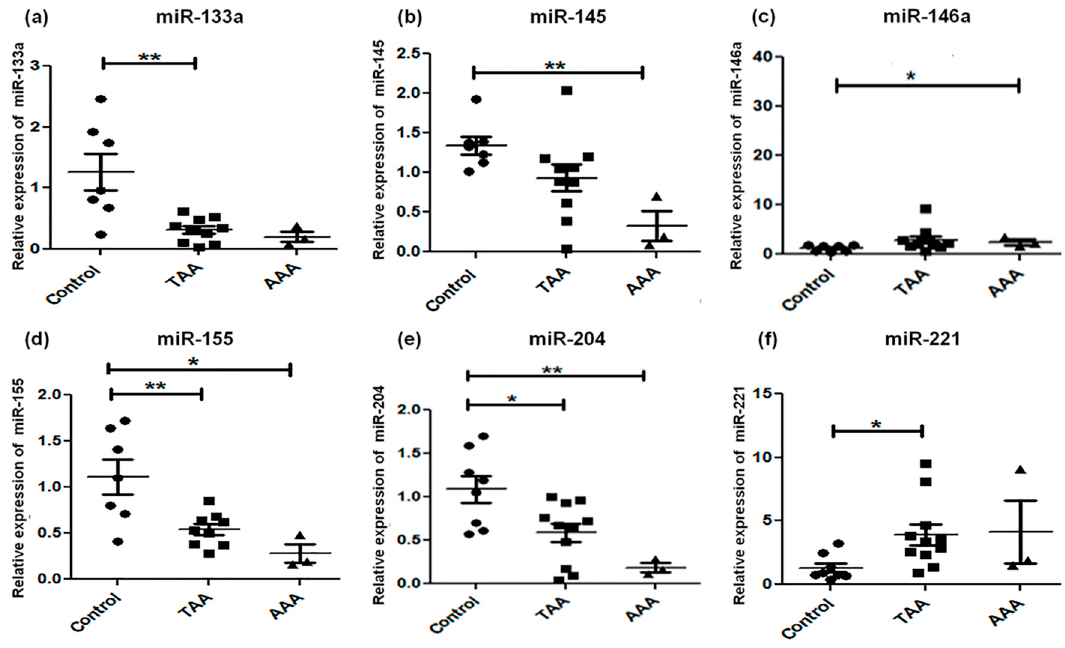
Figure 2. Alteration in microRNA profiles of miR-133a ( a ), miR-145 ( b ), miR-146a ( c ), miR-155 ( d ), miR-204 ( e ), and miR-221 ( f ) by qRT-PCR. Expression levels in TAA ( n = 11) and AAA ( n = 3) as compared with non-aneurysmal control aorta ( n = 8). The relative amount of each miRNA was normalized to RNU44. Statistically significant differences: * p < 0.05, ** p < 0.01.